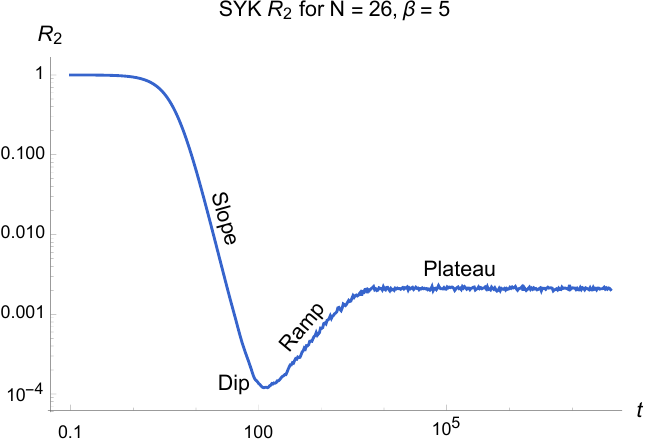
Figure 1 . The 2-point spectral form factor for SYK with N = 26 Majoranas at inverse temperature (cid:12) = 5, computed for 1000 random samples. The slope, dip, ramp, and plateau are